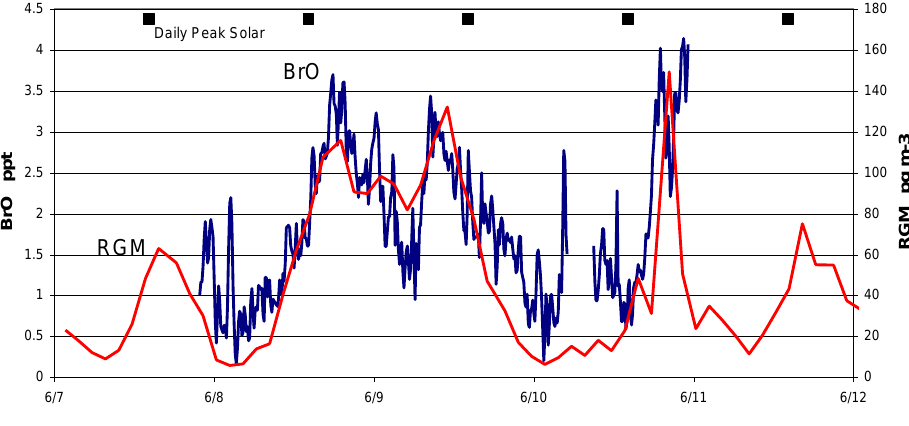
Fig. 9. RGM and BrO from CIMS, 2007 ( r = 0 .